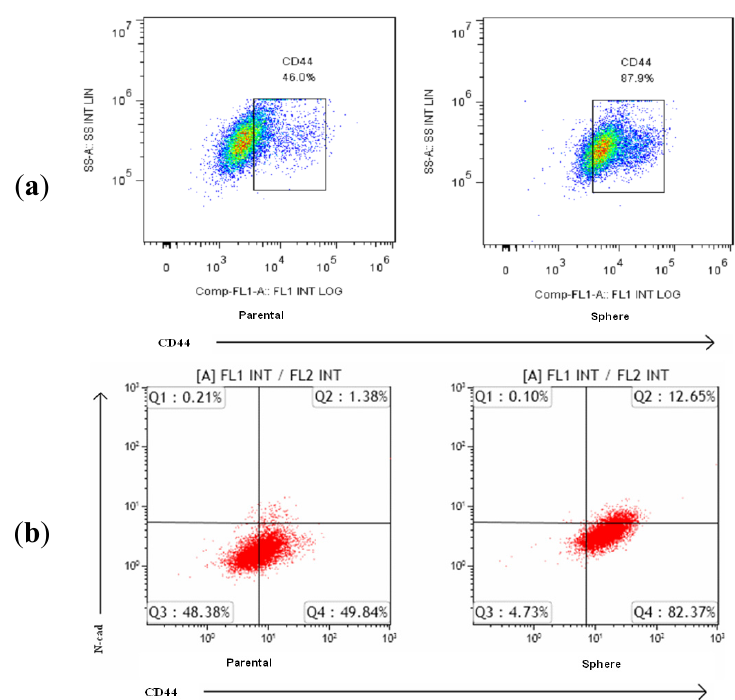
surface marker CD44 expression. ( a ) The TW06 sphere-derived cells displayed higher CD44 expression than the parental cells did; ( b ) Flow cytometric analysis of CD44 and N -cad expression in the TW06 sphere-derived cells and parental cells.